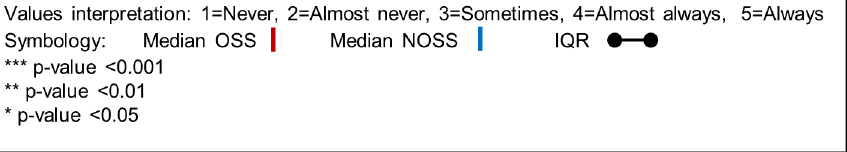
Fig 2. Comparison between frequencies of household dengue prevention practicesby outdoor spatial spraying perception.